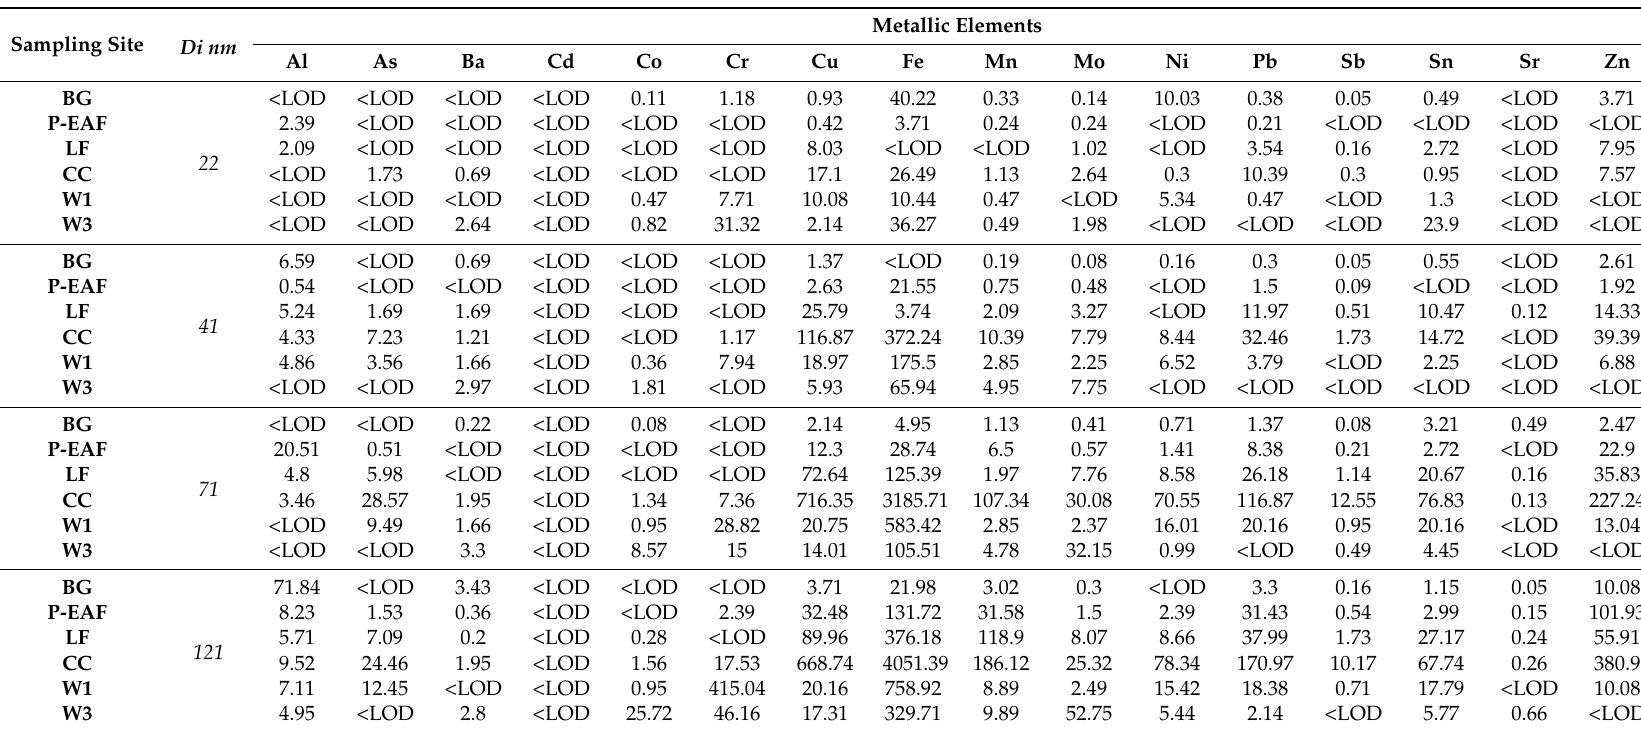
Table 5. Concentration (ng/m 3 ) of the metallic elements determined in the UFPs collected by ELPI+ for each size range in BG, P-EAF, LF, CC, W1 and W3. Sampling